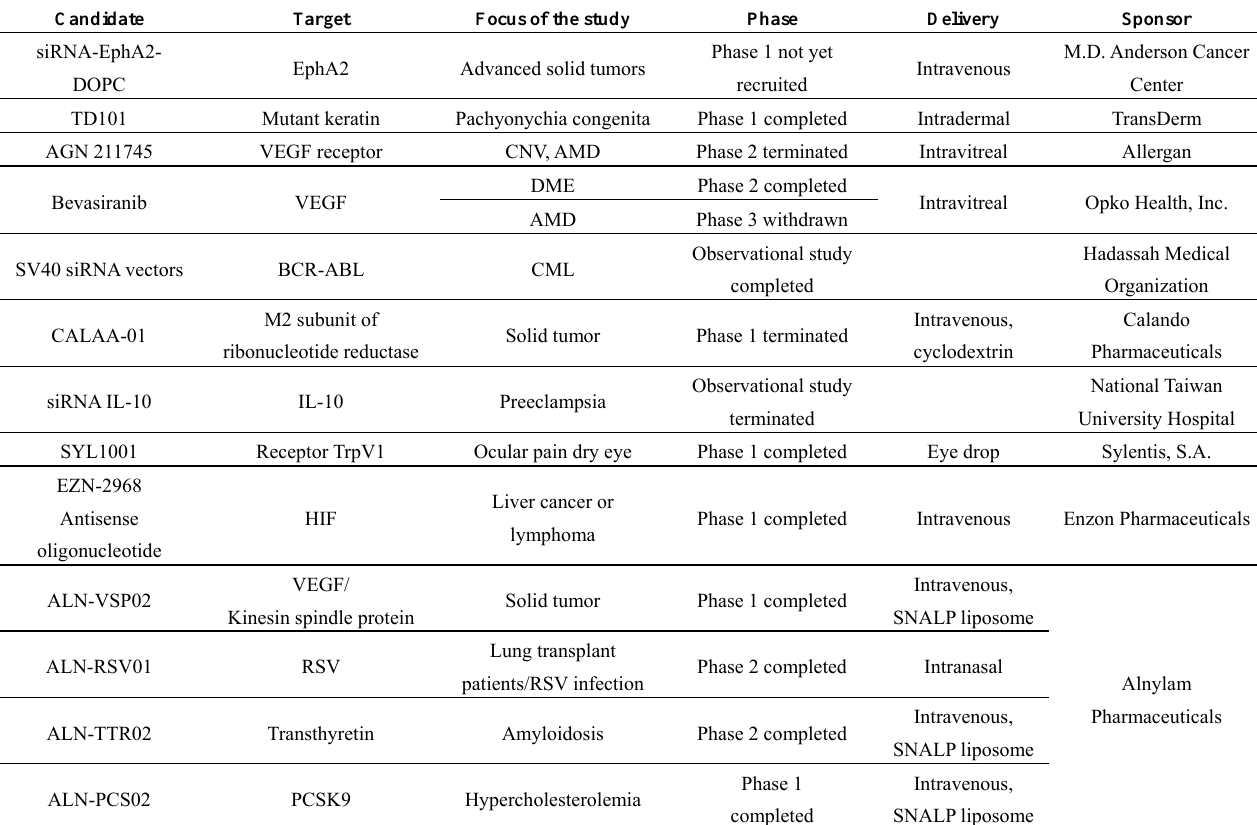
Table 3. RNAi-based therapies: Early stage clinical